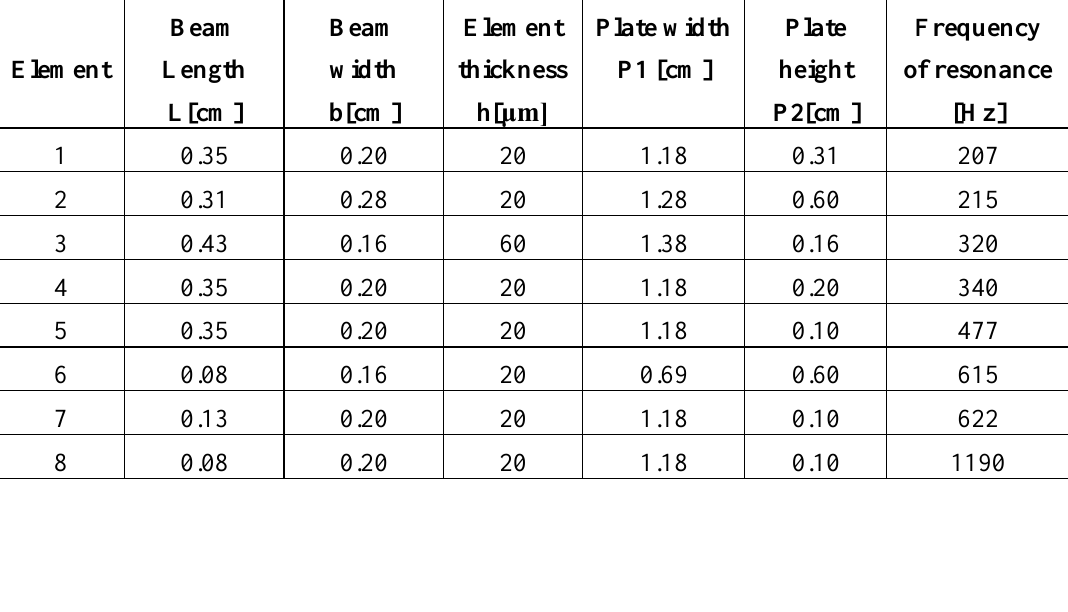
Table 1. Dimensions of the tested elements.